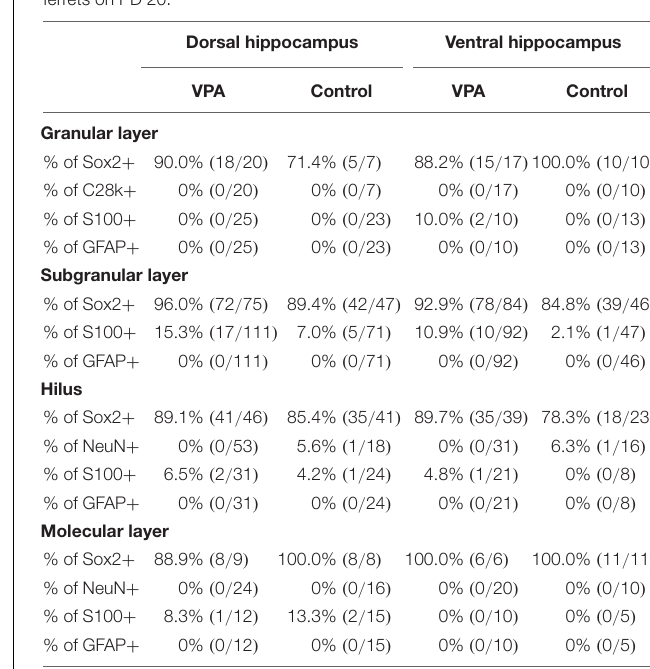
FIGURE 3 | The 5-bromo-2-deoxyuridine (BrdU)-labeled cell density and BrdU-labeled Sox2-immunopositive progenitor density in the dentate gyrus of dorsal and ventral hippocampi in postnatal day (PD) 20 ferrets. (A) BrdU-labeled cell density. (B) BrdU-labeled Sox2-immunopositive progenitor density. Data are shown as mean ± SEM. Significance is indicated using Scheffe’s test at * P < 0.001; number of hippocampi = 8; GL, granular layer; ML, molecular layer; SGL, subgranular layer.